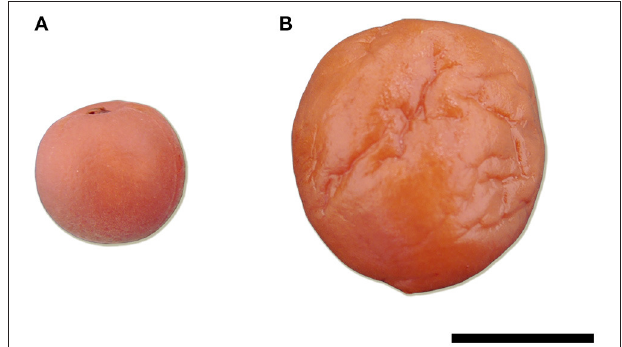
FIGURE 1 | Photograph of Karikari-ume, unripe ume fruit salted pickle which has a hard texture (A) and Umeboshi, ripe ume fruit salted pickle which has a soft texture (B) . Scale bar =